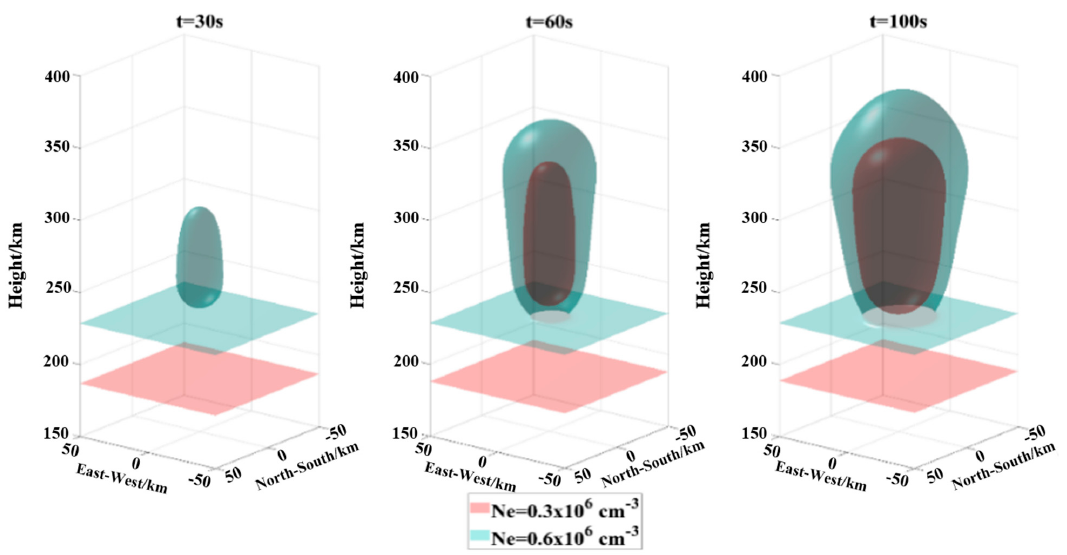
Figure 2. The 3D isosurface of electron density after CO 2 release.